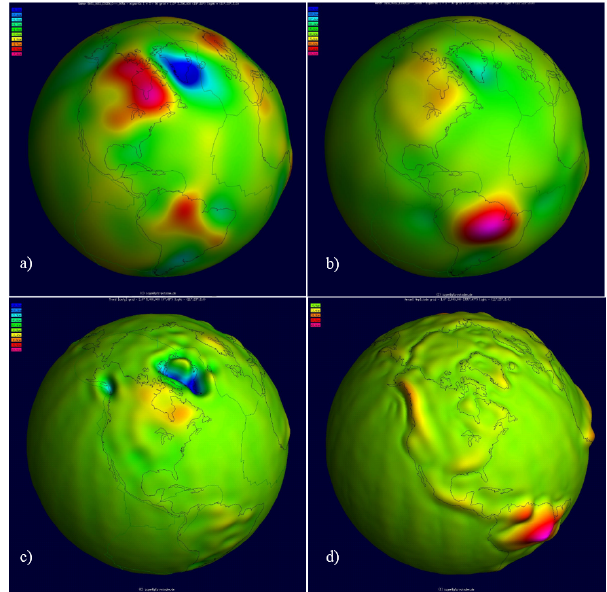
Figure 15. Snapshot of visualization service for temporal mod- els (a) EWH in January 2009 and (b) EWH in May 2009. Note that the EWH difference between the 2 months represents the mass change trend (c) . Note the strong effect due to the GIA in the Hud- son Bay area, Canada, and ice melting in Greenland and Alaska.